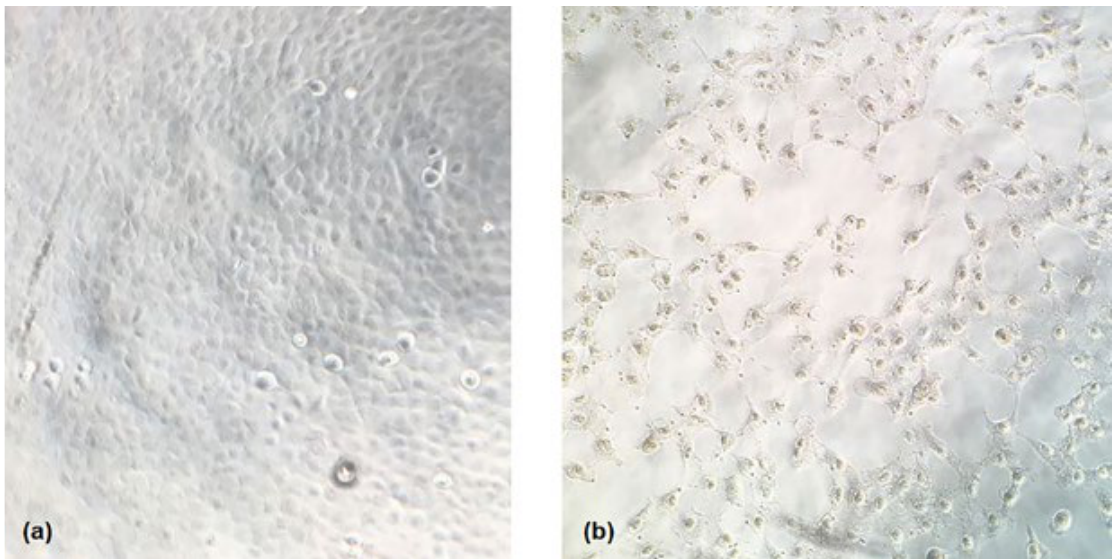
FIGURE 1 – Monolayer sheet of untreated and treated A549 cells. (a) The normal cells were polygonal with well-defined and complete monolayer (untreated cells, negative control). (b) Cells treated with large concentrations of extracts did not form a complete monolayer and tends to appear tense cytoplasm, black nuclei in the centre. The cells were observed after 6 days at SC and under inverted microscope at 200× magnification. of the extracts against A549 and VERO cells, using the MTT and NR TABLE II - CC 50